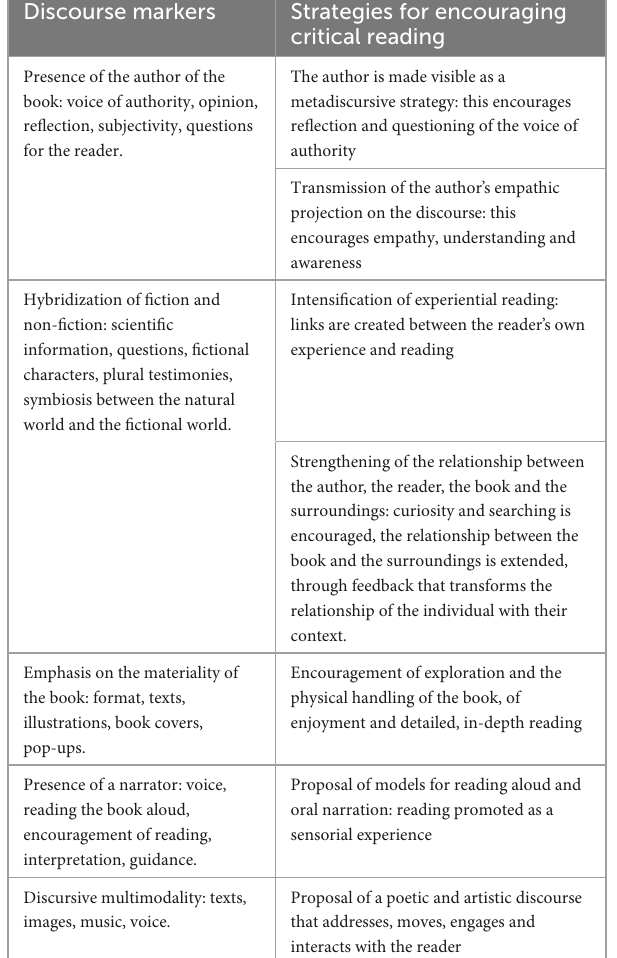
TABLE 11 Discourse markers and strategies